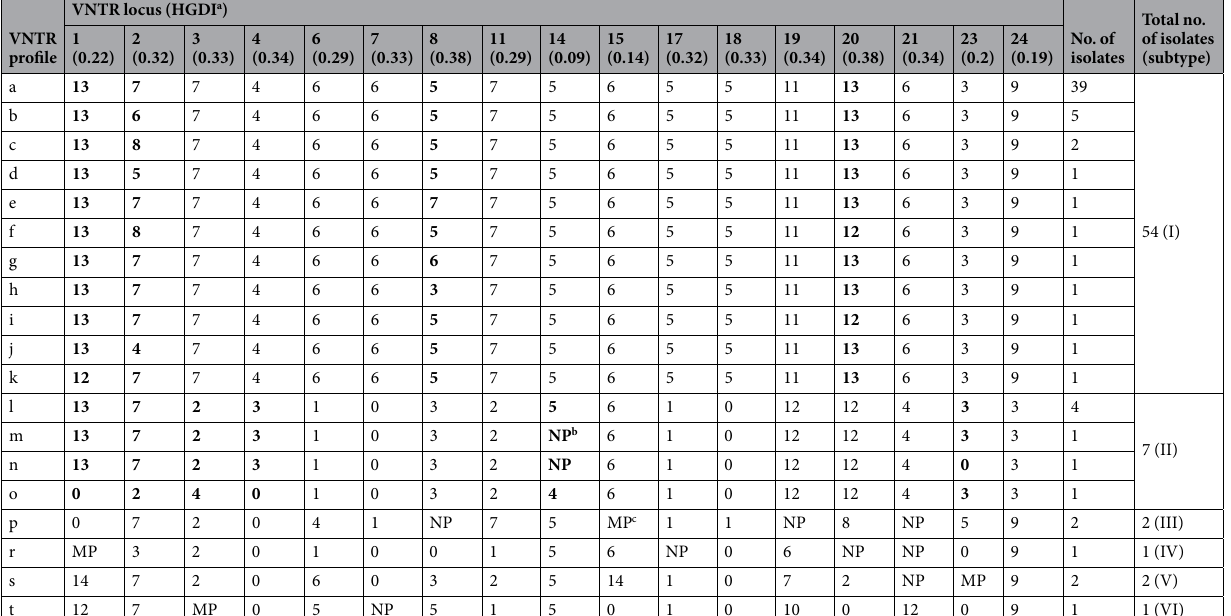
Table 1. VNTR typing profiles of 67 M. kansasii isolates. Bold font indicates VNTR locus at which allelic variability within the same subtype was observed; a The Hunter-Gaston’s discriminatory index; b NP, no PCR product; c MP, multiple-band